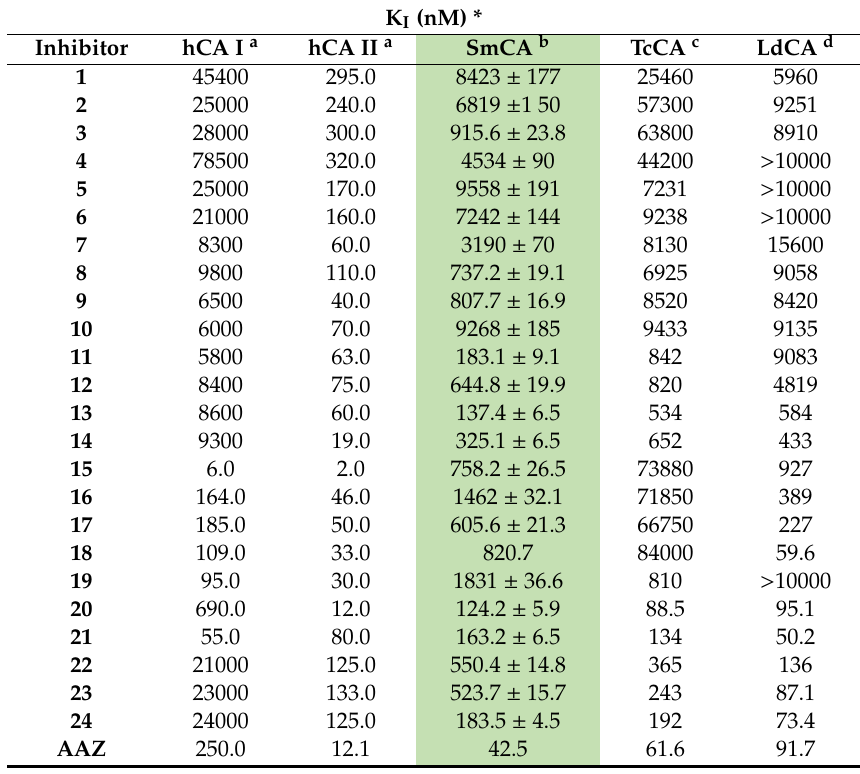
Table 2. Inhibition of S. mansoni SmCA (green column) compared with human carbonic anhydrase isoforms hCA I and hCA II, as well as protozoan CAs from T. cruzi (TcCA) and L. donovani (LdCA), using sulfonamides 1 − 24 and as assessed by the stopped-flow CO 2 hydrase assay [29]. K I (nM) * hCA I a hCA II